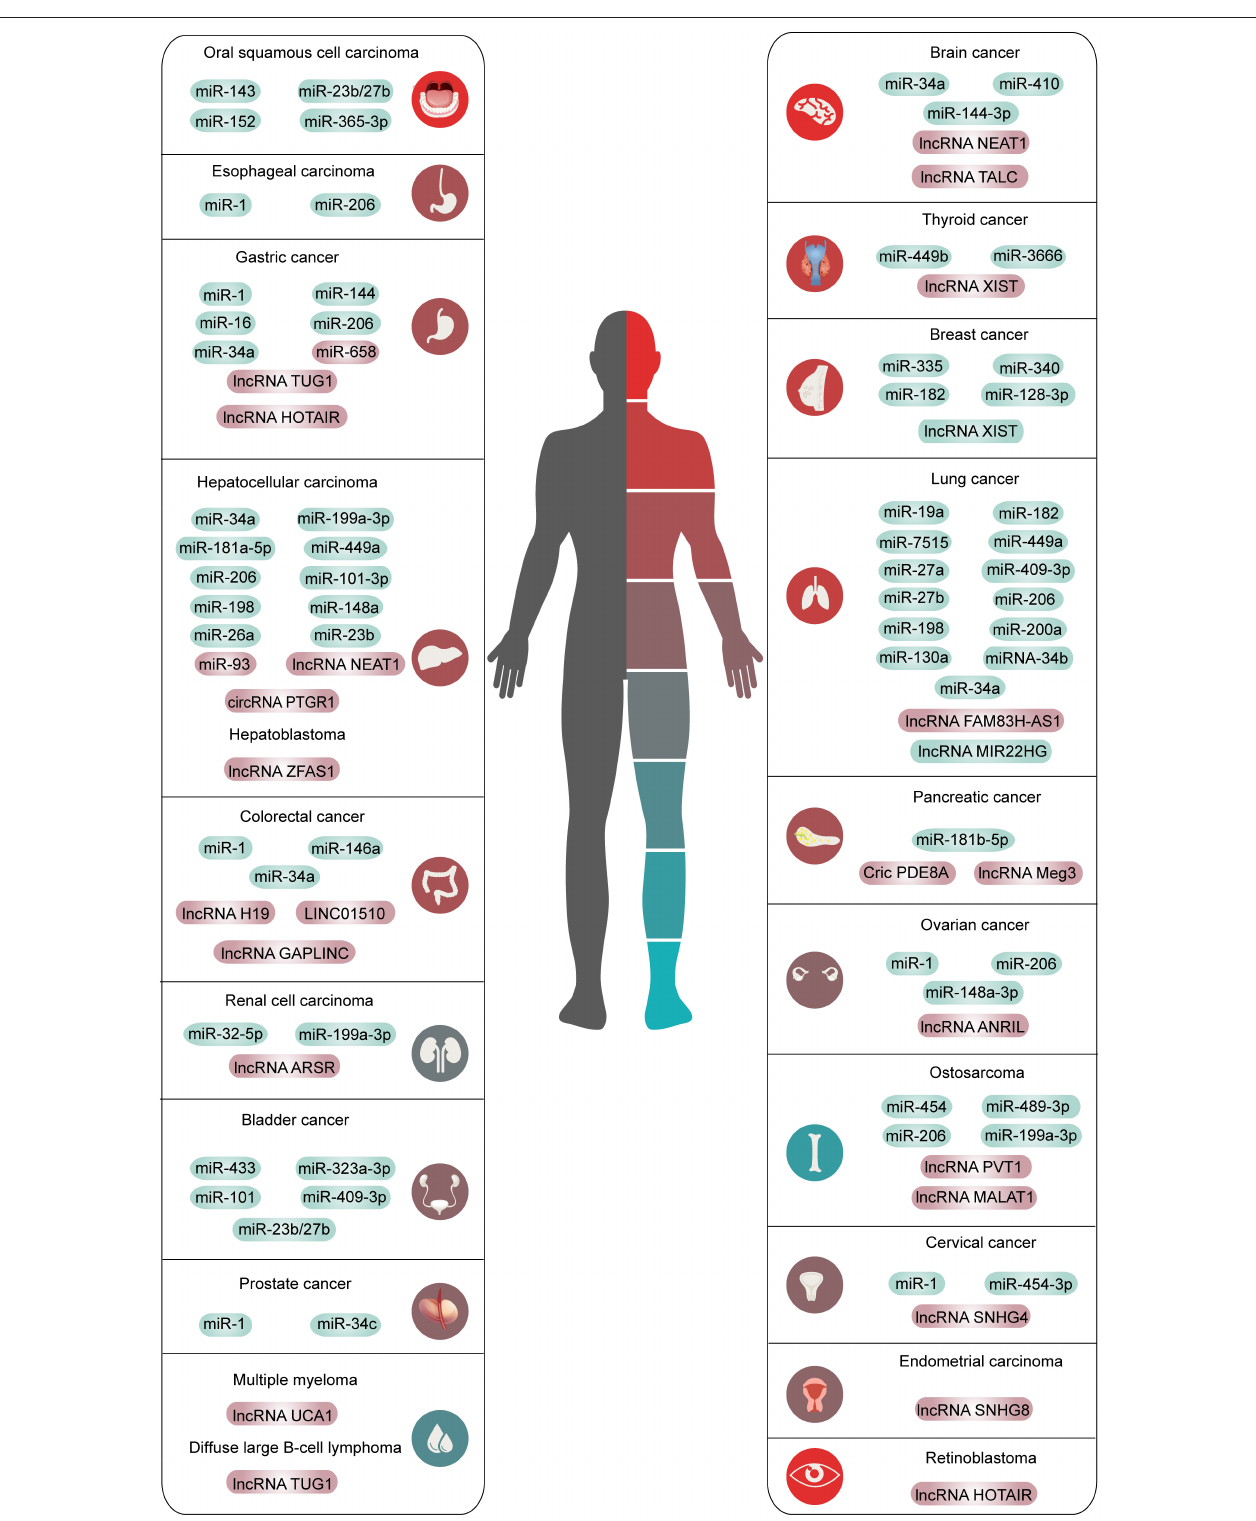
FIGURE 2 | The overview of ncRNAs interacted with HGF/c-Met axis in human common malignancies. The red means high expression and the green means low expression.